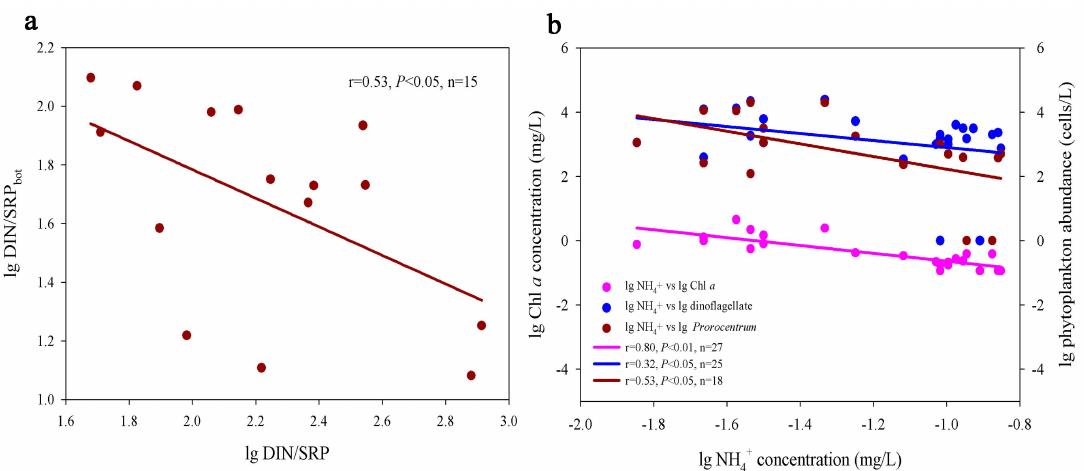
Figure 3. Correlations between the dissolved inorganic N and ammonium to soluble reactive P (DIN / SRP) ratio in surface and bottom water of southern region ( a ), correlations between Chl a , abundance of dinoflagellate and Prorocentrum, and NH 4 + concentrations in surface water of Taiwan Strait ( b